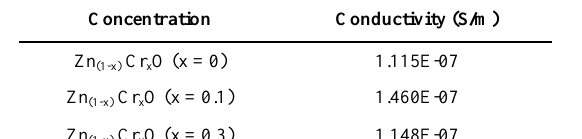
Table 3. Conductivity of Zn (1-x) Cr x O (x = 0, 0.1 and 0.3) nanoparticles.